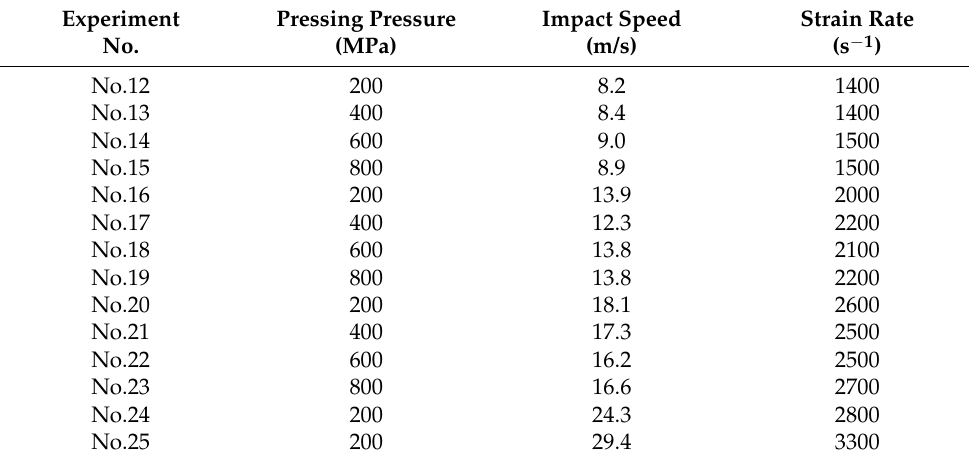
Table 1. The basic experimental parameters of the specimens under different pressing pressures at room